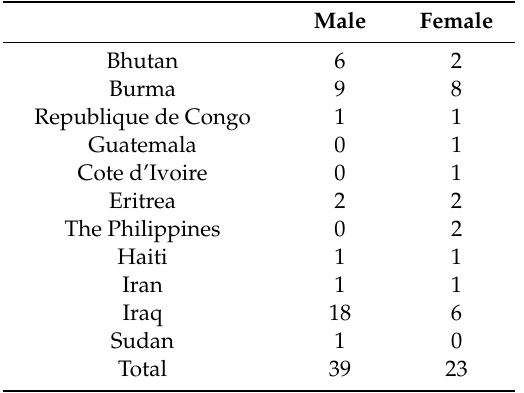
Table 1. Interviewees by gender and country of